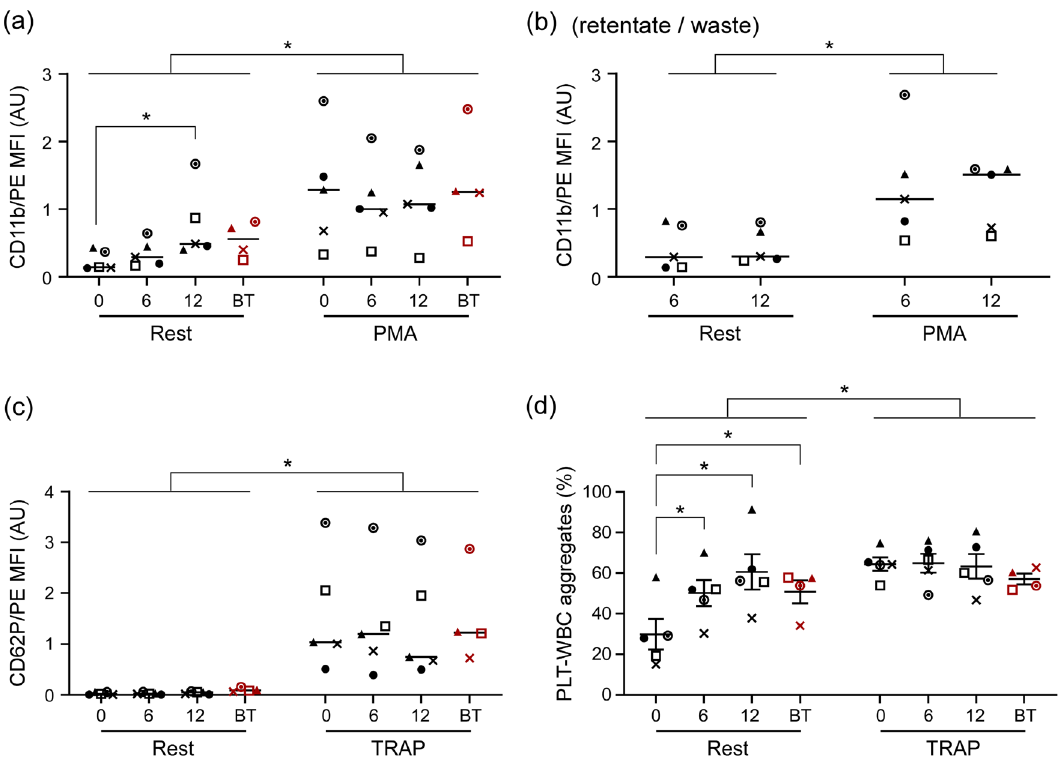
Figure 5. Effect of CIF processing in the recirculation regime on the activation state of WBCs and PLTs. ( a ) Activation of WBCs (CD11b) remaining in the recirculating blood. ( b ) Activation of WBCs (CD11b) removed with the retentate (waste). ( c ) Activation of recirculating PLTs (CD62P). ( c ) Formation of PLT-WBC aggregates in the recirculating blood. Measurements were performed via flow cytometry for samples collected before (round 0), during (round 6), and after (round 12) the recirculation experiment, both at rest and after additional activation with PMA (panels a & b) or TRAP (panels c & d). BT (red symbols) represent blood samples set aside for the duration of each recirculation experiment to assess the effect of time alone on cell activation. Statistical significance is denoted by * for p < 0.05. Each symbol represents a different recirculation experiment (n = 5, using blood from 4 unique